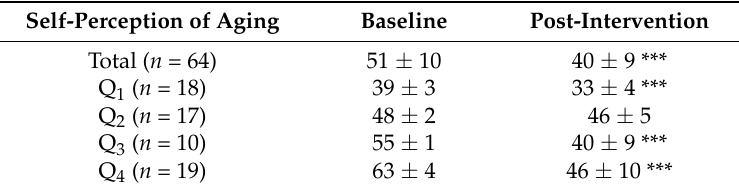
Table 4. Mean score of positive and negative self-perception of aging group’s baseline and post-intervention. Self-Perception of